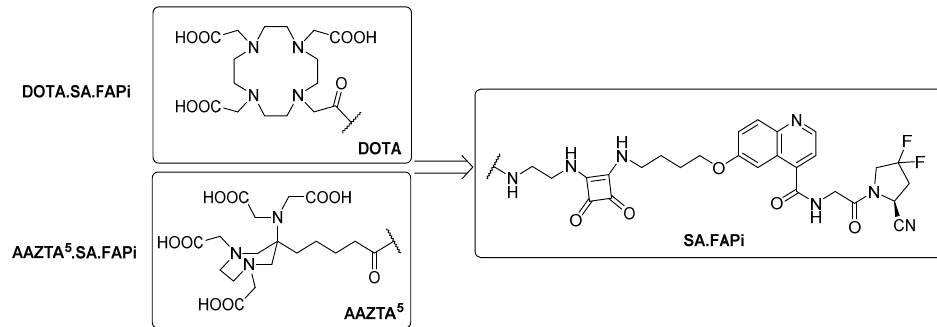
Figure 2. Structures of DOTA.SA.FAPi and AAZTA 5 .SA.FAPi .